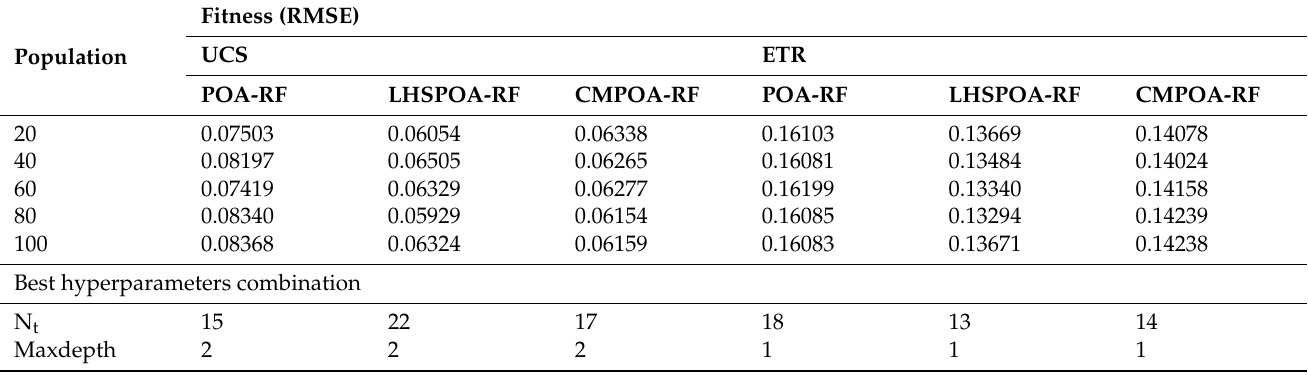
Table 5. The fitness results of the proposed models based on the different population.